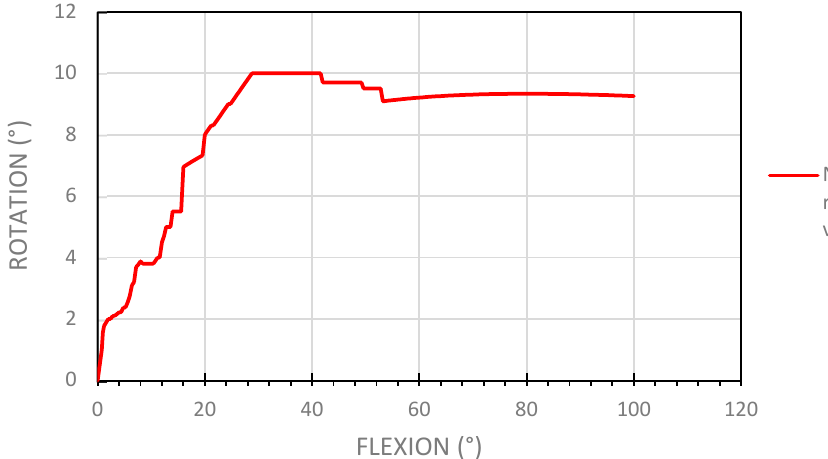
Figure 15. A graph of rotation against flexion of our virtual model.